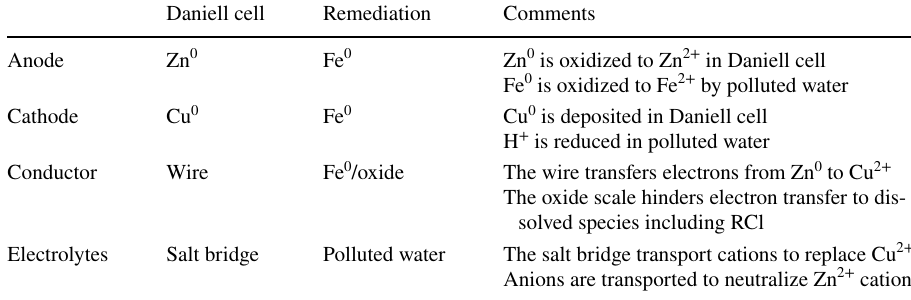
Table 2 Summary of the key features happening in a classical electrochemical cell (Daniell cell) compared to the electrochemical corrosion of water. It is seen that the oxide scale blocks electron transfer, making electrochemical reduction in any contaminants (e.g., RCl)